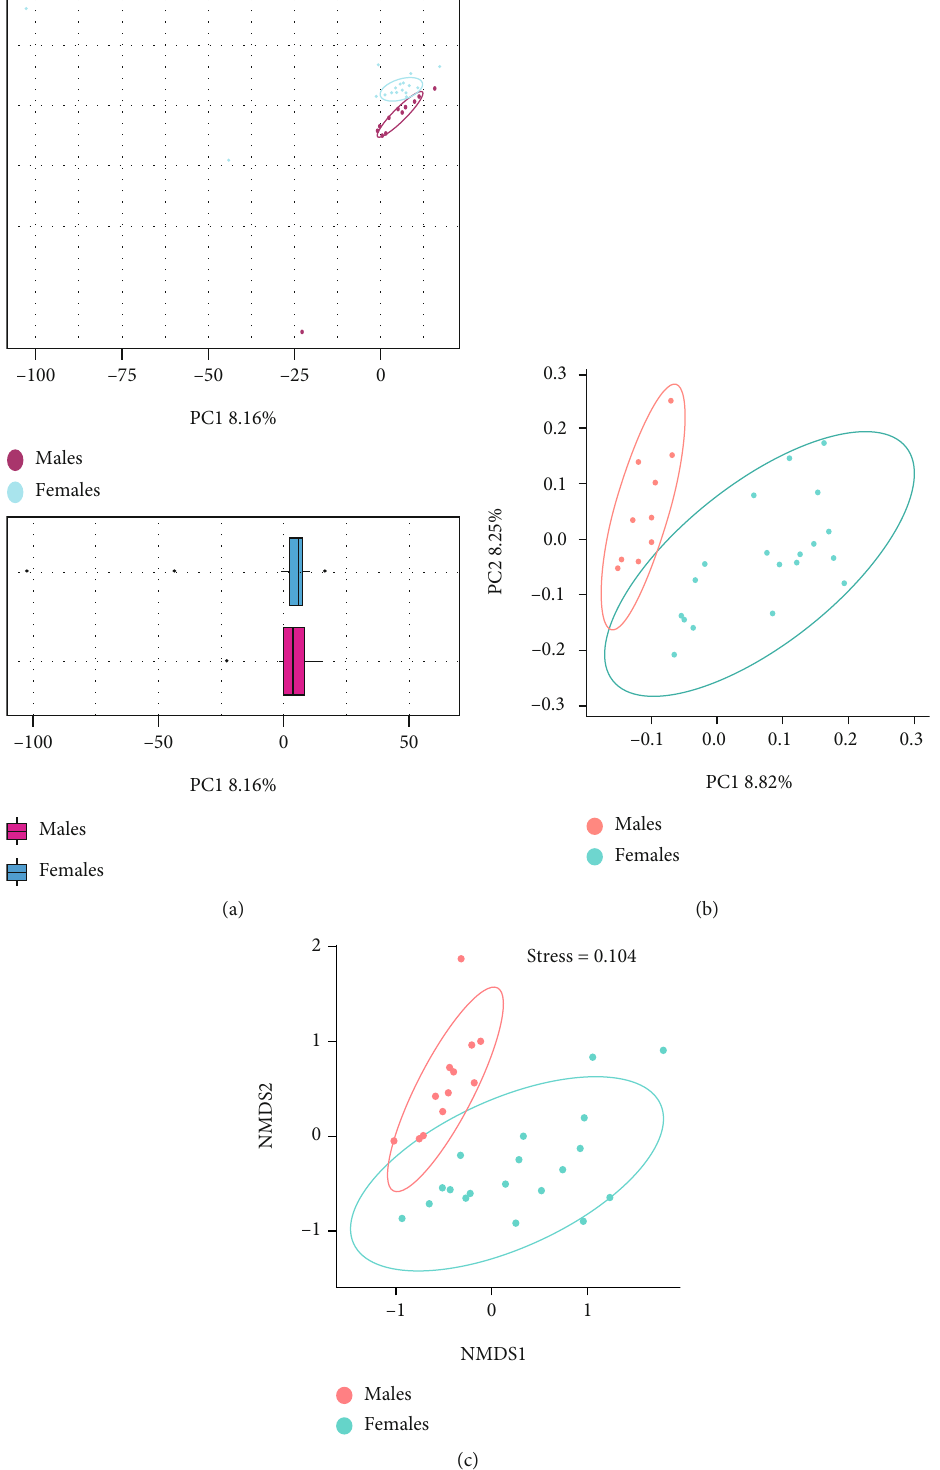
Figure 2: Similarity of microbial communities between elderly males and females with stage 1 periodontitis based on the unweighted UniFrac distance. (a) 2D diagram of principal component analysis (PCA). (b) 2D diagram of principal coordinate analysis. (c) 2D diagram of nonmetric multidimensional scale (NMDS) used to analyze the β -diversity of microbial communities between males and